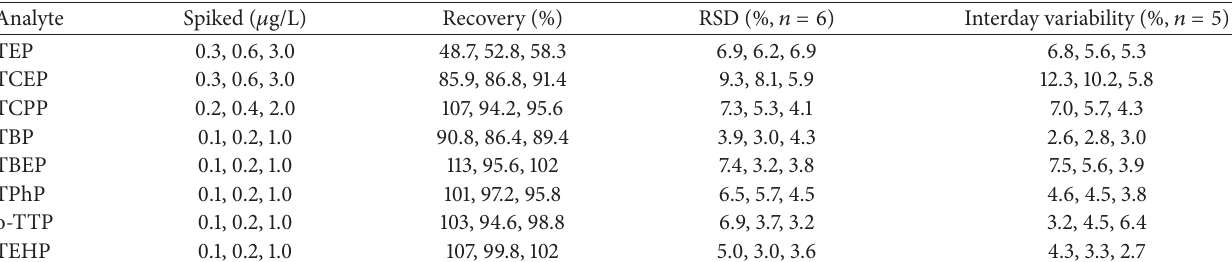
Table 3: Recoveries and precisions of OPEs.